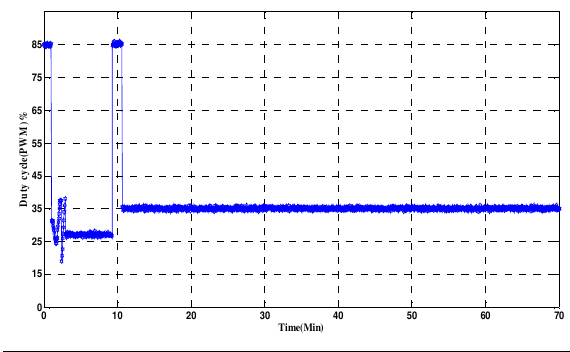
Fig. 12. Duty cycle control of ESP power supply. During this period of operation the electrostatic voltage is increased from (0-24) Kv in the first 4 min and increased to the nominal 60 Kv after 10 min as shown in Fig.13. Both Fig.12. and Fig.13 shows smooth operation with a little bit of perturbation between transient and steady state region.